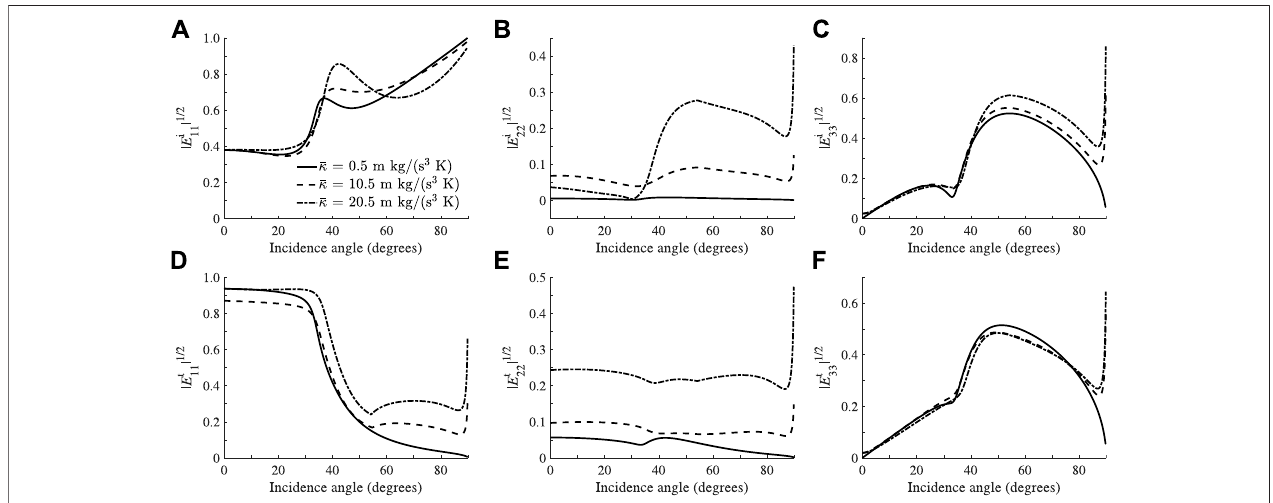
FIGURE 13 | Same as Figure 12 but for the square root of the energy ratios of the re fl ected P (A) , re fl ected T (B) , re fl ected S (C) , transmitted P (D) , transmitted T (E) and transmitted S (F) waves, considering the fl ux in the z -direction.